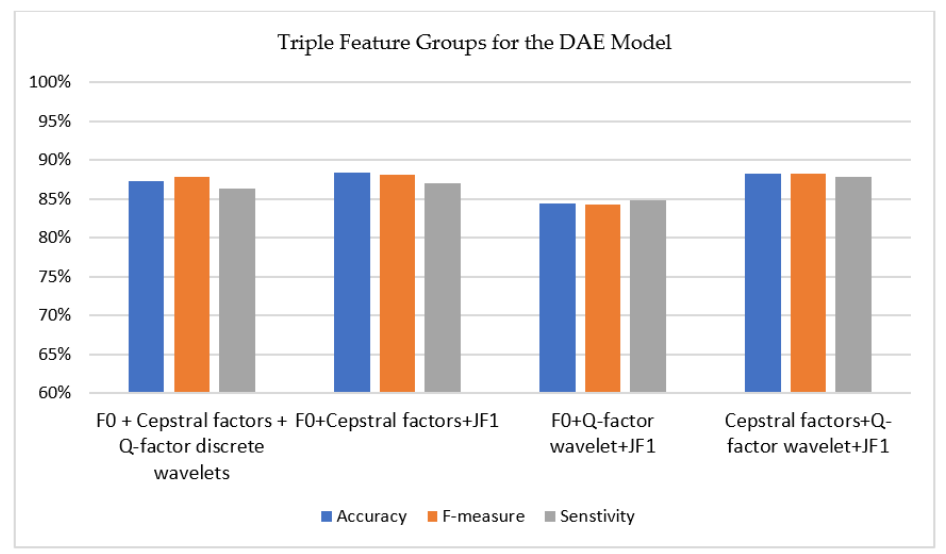
Figure 4. Performance results for triple feature groups for DAE. Table 10. Model Joining: Double Feature Groups for proposed.